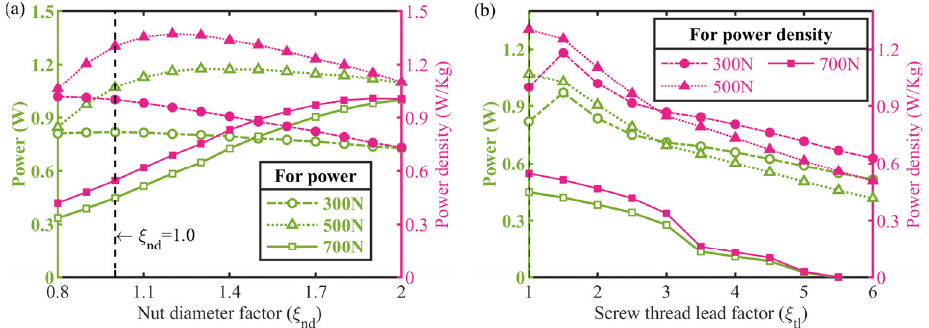
Figure 13. Effects of critical parameters in clamping components on actuator output. Both power and power density versus: ( a ) nut diameter factor, ( b ) screw thread lead factor.